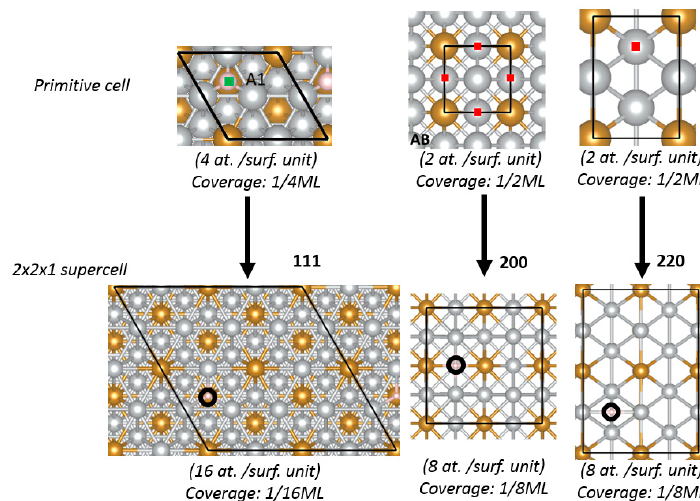
Figure 5. Slab models for all three Ni 3 TM 1 (111), (200) and (220) facets constructed from the primitive cell. The locations marked by black circles indicate the H adsorption sites with the lowest energy.